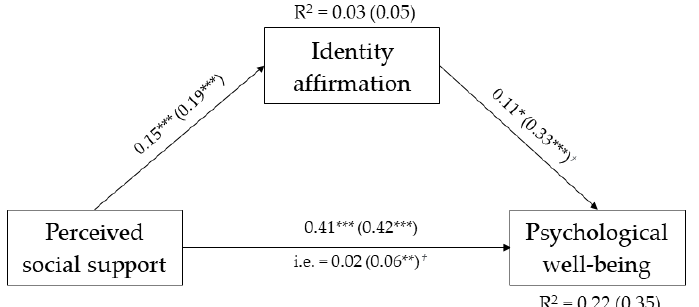
Figure 2. Multiple group mediation model for gender identity. Standardized path coefficients are reported. Parameters for non ‐ binary trans are shown in brackets, † stands for signi fi cant di ff erences between the groups. ** p < 0.01 *** p < 0.001. Cohort groups are not included in the figure for the sick of